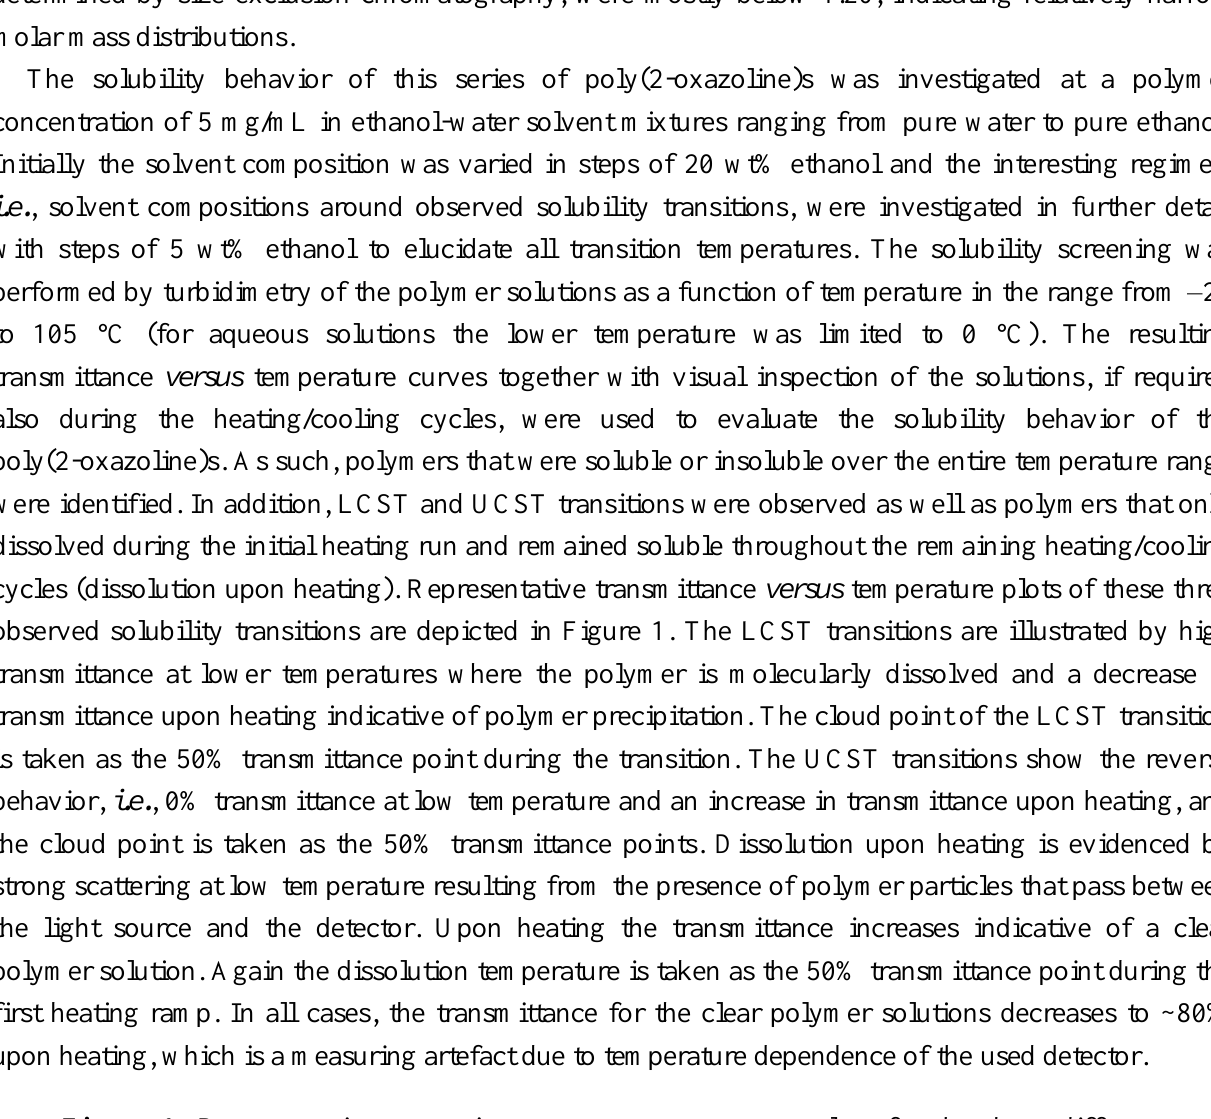
Figure 1. Representative transmittance versus temperature plots for the three different phase transition phenomena that were observed for polymer solutions in this contribution, namely LCST and UCST behavior as well as dissolution upon